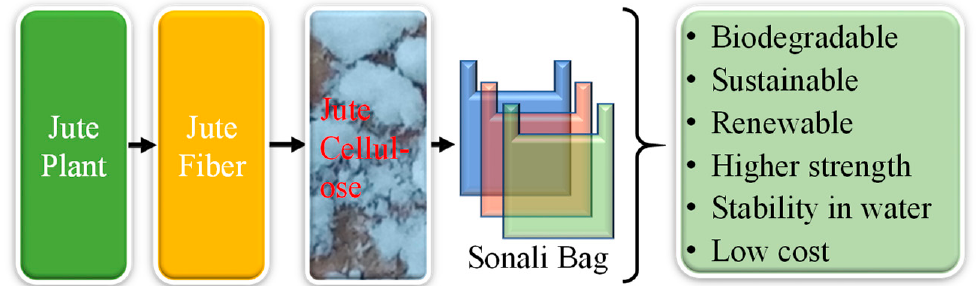
Figure 24. Jute-based biodegradable polybag production.